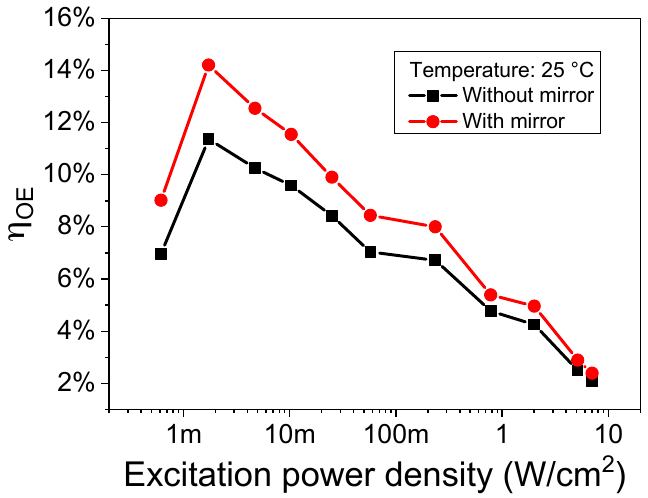
Figure 6. Variation in efficiency when a generic broadband mirror is placed below the receiver to compensate for partial absorption.